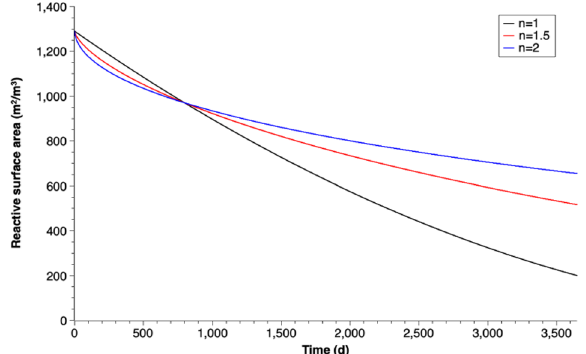
Figure 9. Reactive surface area of Fe 0 particles versus time (n is the coefficient of passivation).